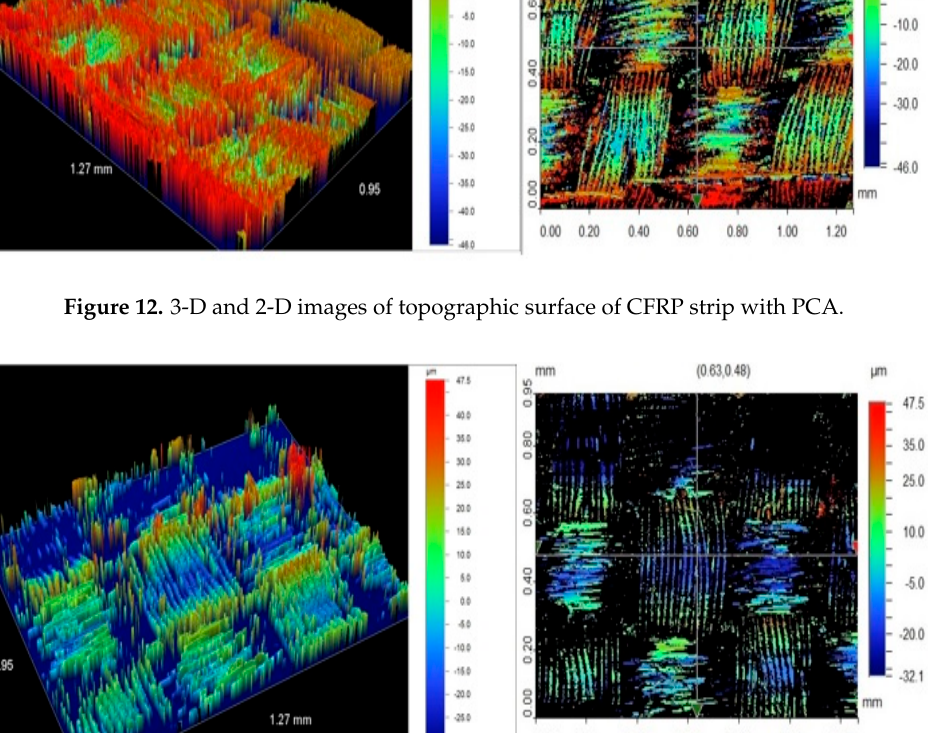
Figure 13. 3-D and 2-D images of topographic surface of CFRP strip with EA.